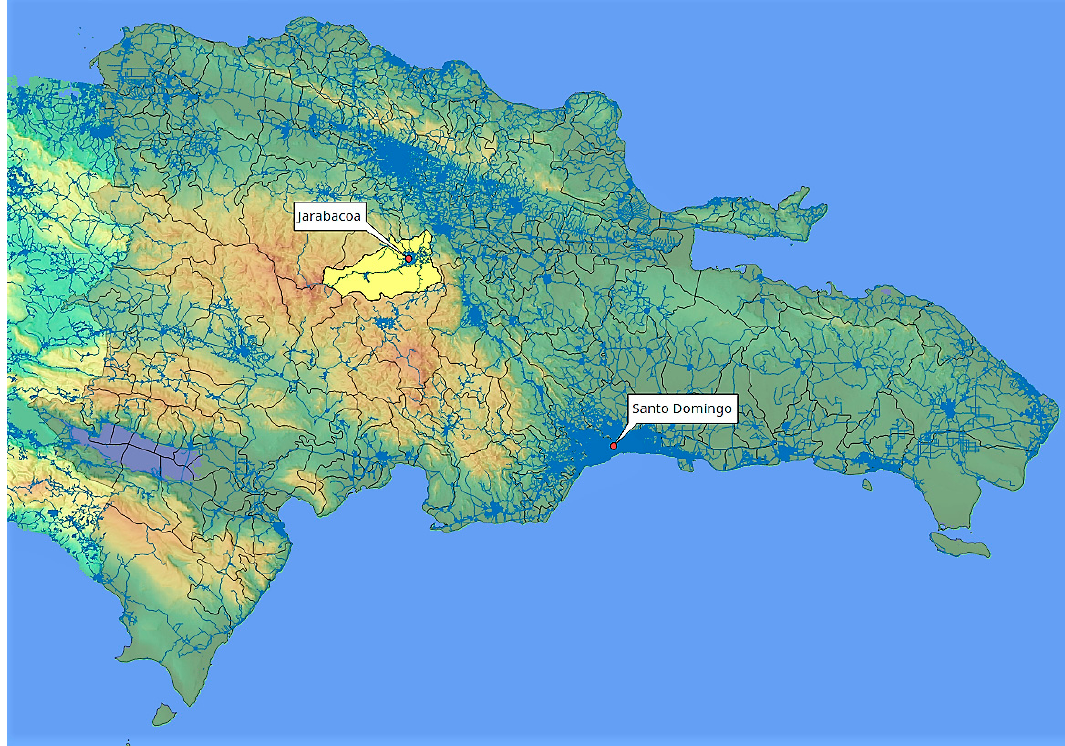
Figure 1. Overview of geographical location of the study site (Jarabacoa, province La Vega).